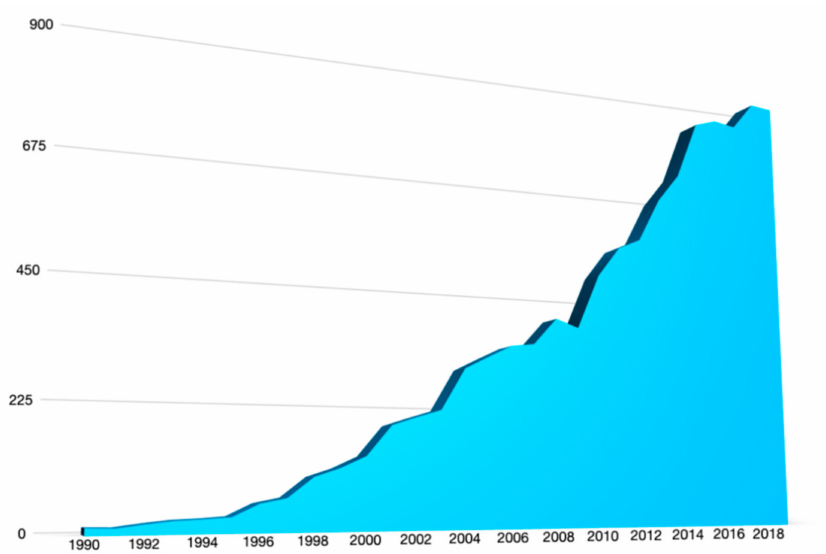
Figure 6. Number of publications per annum returned by PubMed when using search terms “biosen- sor” and “bacteria”